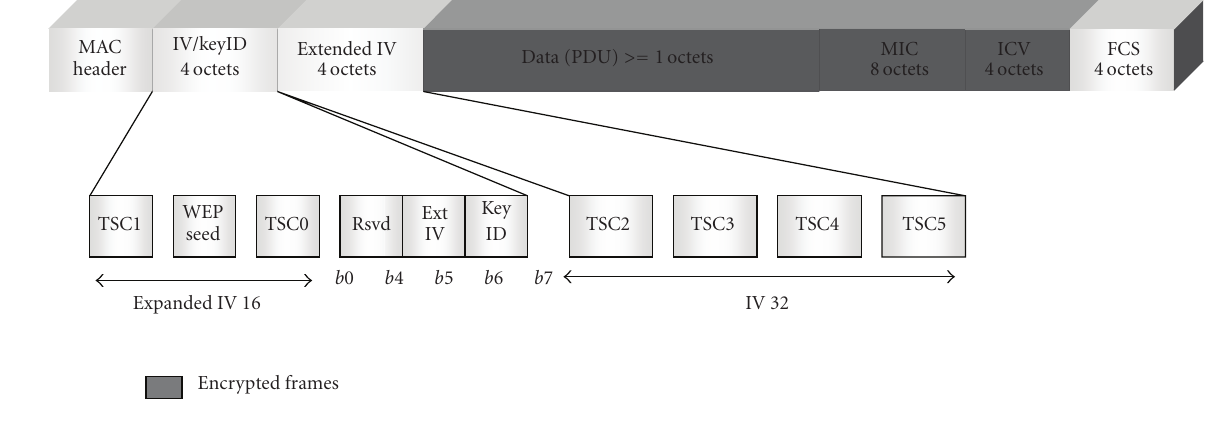
Figure 3: WPA MPDU